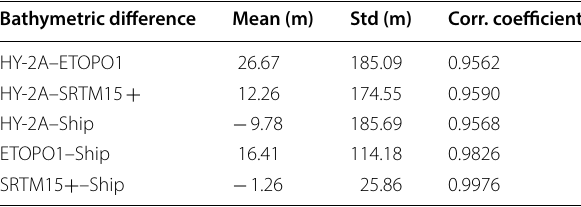
Table 9 Performance of HY-2A-derived bathymetry Bathymetric difference Mean (m) Std (m) Corr.